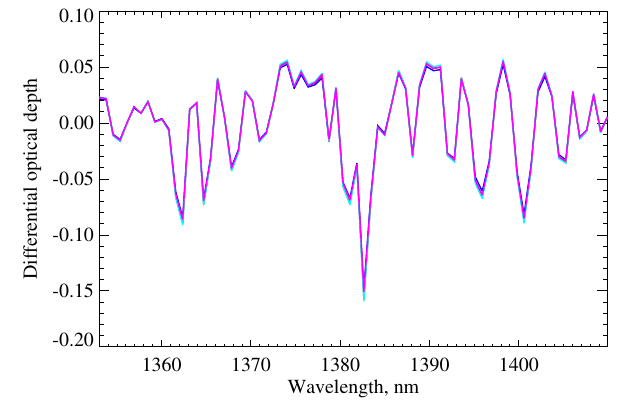
Fig. 3. Simulated limb radiance at a tangent height of 15km, a solar zenith angle of 69 ◦ , and a relative azimuth angle of about 40 ◦ (both angles are defined at the tangent point). Magenta line: standard sim- ulation considering multiple scattering, background aerosols, and surface albedo of 0.5. Blue line: single scattering approximation including background aerosols. Cyan line: multiple scattering with- out stratospheric aerosols (above 10km) with surface albedo set to 0.5. Red line (barely seen below the cyan line): Rayleigh scat- tering (including multiple scattering) with surface albedo set to 0.